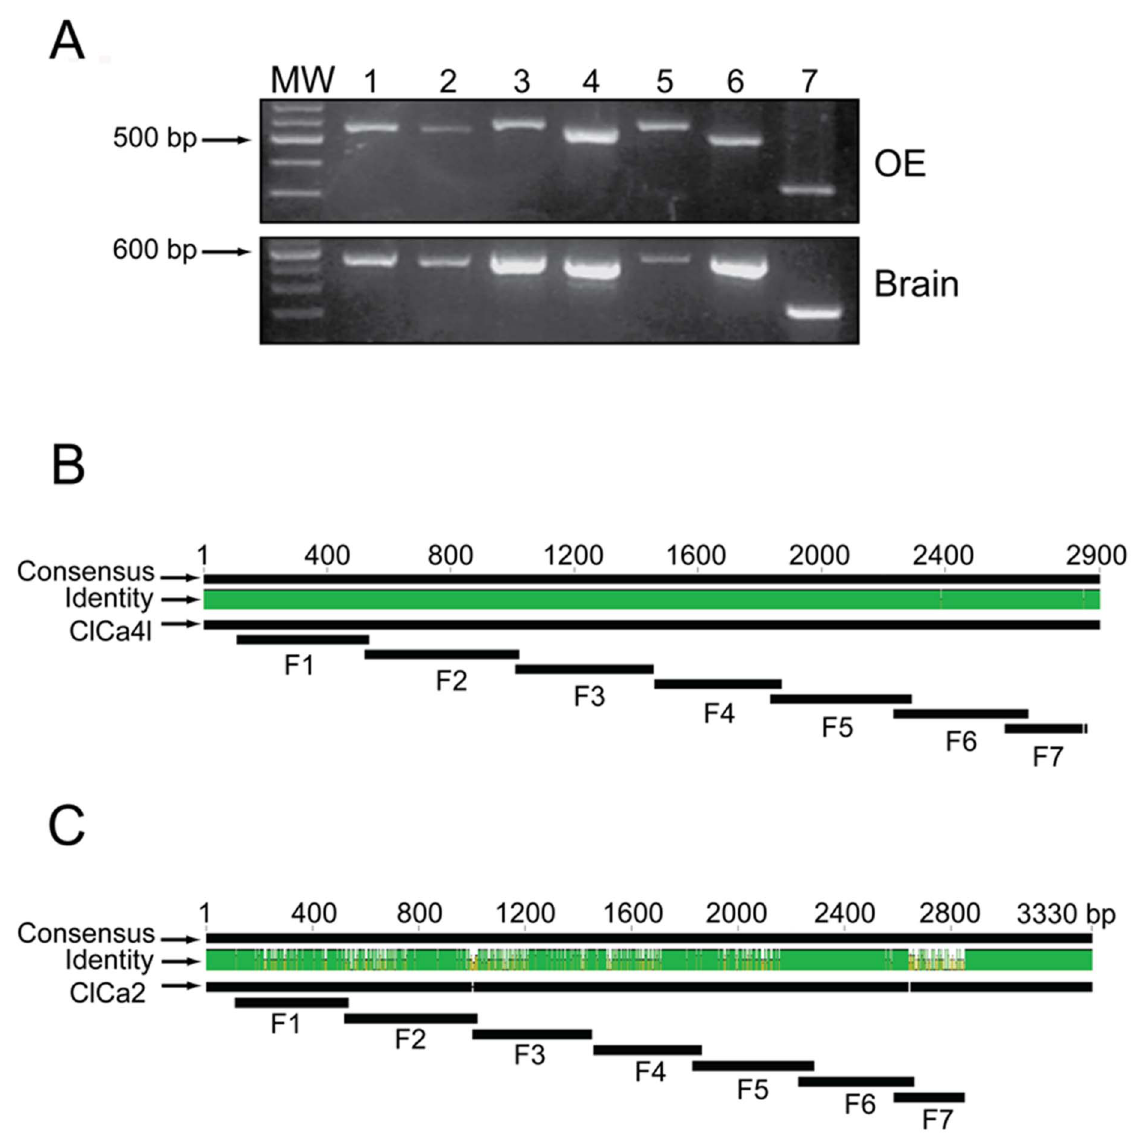
Figure 3. Complete sequence of ClCa channels in rat OE. A. Amplicons of seven fragments comprising the entire cDNA sequence of the ClCa2 and ClCa4l channels of rat olfactory epithelium and brain (positive control). B. The black boxes correspond to the nucleotide alignment of the seven cDNA fragments (F1 to F7) with the ClCa4l sequence. Green denotes identity and white denotes difference in nucleotide sequence. C. Nucleotide alignment of the seven cDNA fragments (F1 to F7) with the ClCa2